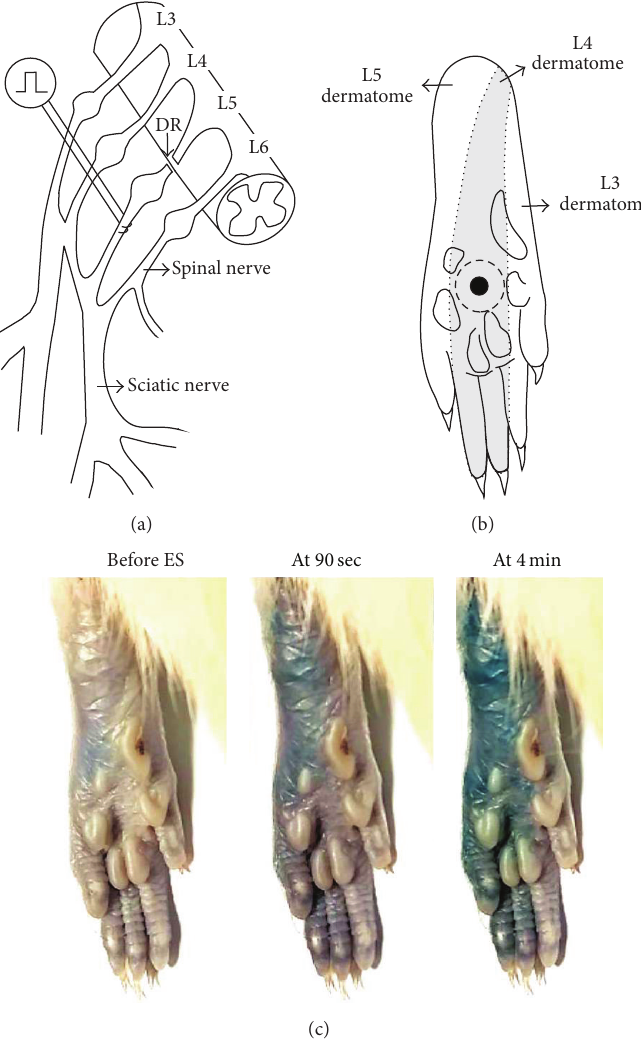
Figure 1: The locations of electrical stimulation (ES), intraplantar (i.pl.) injection of substances, and paw sensitivity testing and an example of ES-induced plasma extravasation. (a) An L5 spinal nerve (SN) was decentralized by L5 dorsal rhizotomy (DR). A high-level tetanic ES (2–4 mA, 0.5 ms pulse, 4 Hz, and 5 min) was applied to the decentralized L5 SN 4–6 mm distal to the L5 dorsal root ganglion (DRG). (b) The tactile sensitivity testing was performed in an area (marked by a filled circle) located in the center of the circle surrounded by the tori, which is almost matched to the midpoint of the L4 plantar dermatome (shaded area) [29] of the hind-paw. A 30 𝜇 L i.pl. injection of different substances was administered subcutaneously into the skin area subjected to tactile sensitivity testing, forming a bleb that disappeared within 10min after the injection (bleb area marked by a dotted circle). (c) Following Evans blue injection (i.v., 30 mg/kg, and 2% solution), areas of plasma extravasation induced by the ES of the L5 SN are seen as blue. Note that dye extravasation covered the L5 plantar dermatome within the first 90 seconds of the ES, and the extravasation area extended to the L4 plantar dermatome within 4 minutes of the